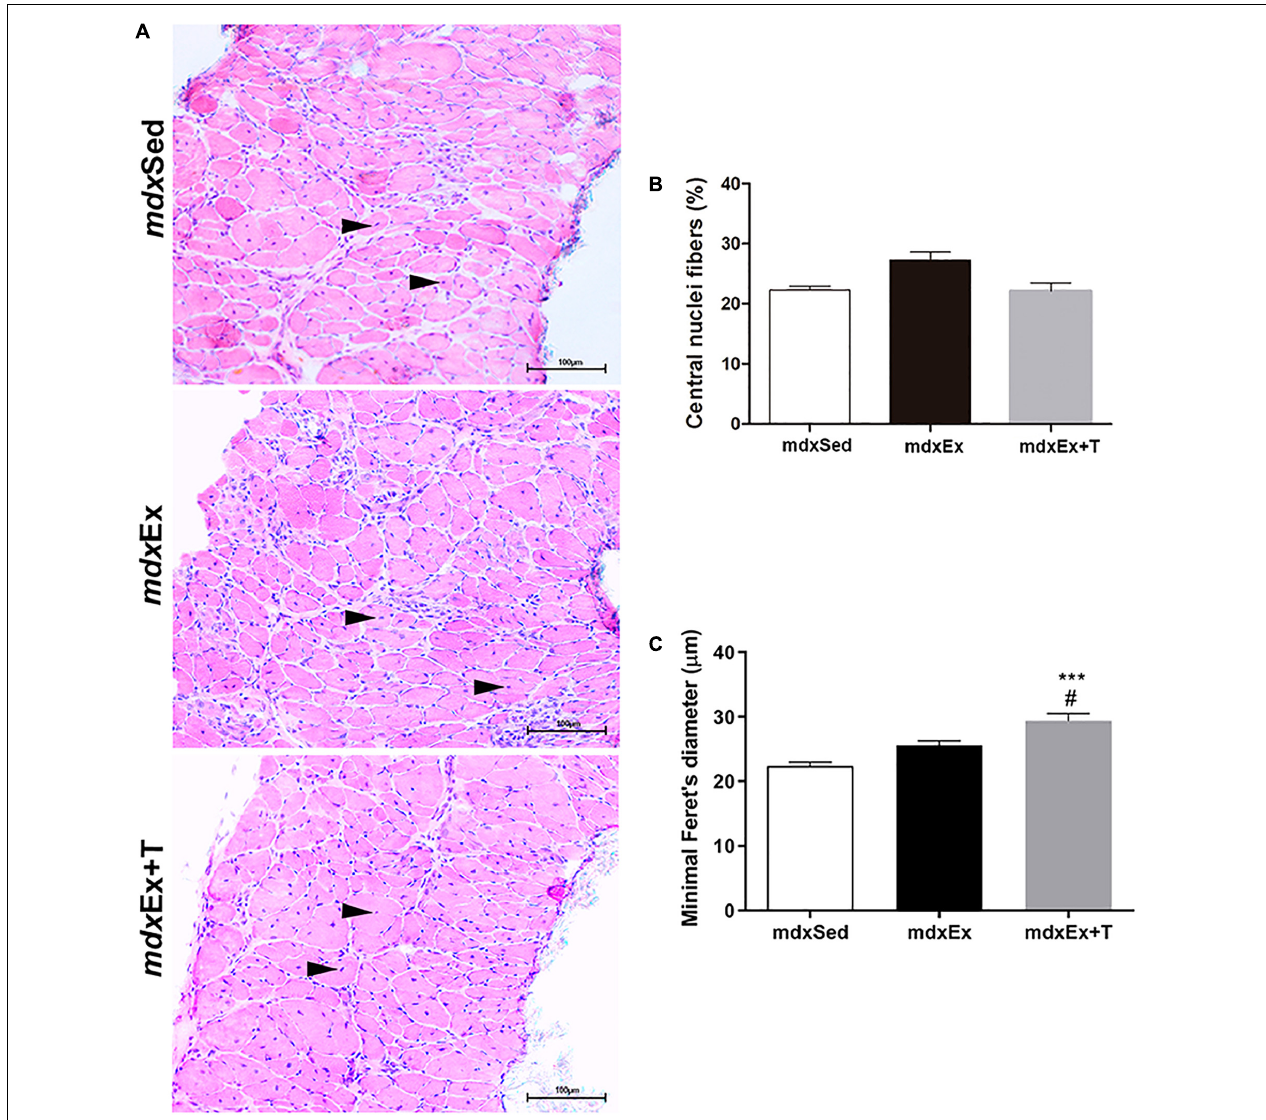
FIGURE 2 | Tempol effects on the regenerative muscular process. (A) Diaphragm (DIA) cross-sections showing fibers with central nuclei (black arrowheads) in the sedentary mdx mice (mdx Sed), exercise trained mdx mice ( mdx Ex), and exercise trained mdx mice treated with Tempol ( mdx Ex+T). (B) Graphs show the nuclei central fibers (%) in the DIA muscles of the mdx Sed, mdx Ex, and mdx Ex+T groups. (C) Graphs show the cross-sectional size (Minimum “Feret’s diameter; µ m) of the fibers with central nuclei in the DIA muscles of the mdx Sed, mdx Ex, and mdx Ex+T groups. All values expressed as mean ± standard deviation (SD). *** P ≤ 0.0001 compared with the mdx Sed group, # P ≤ 0.05 compared with the mdx Ex group (one-way ANOVA with Tukey’s post hoc